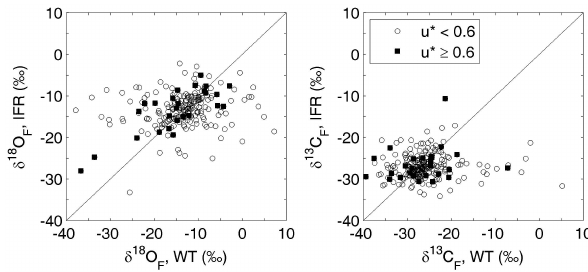
Fig. 7. Relationship between half-hourly isotopic ratios of the CO 2 flux near the forest floor ( δ 18 O F and δ 13 C F ) estimated using a La- grangian dispersion analysis (WT analysis) and flux ratio method in the understory of a deciduous forest. u ∗ is the friction velocity (ms − 1 )